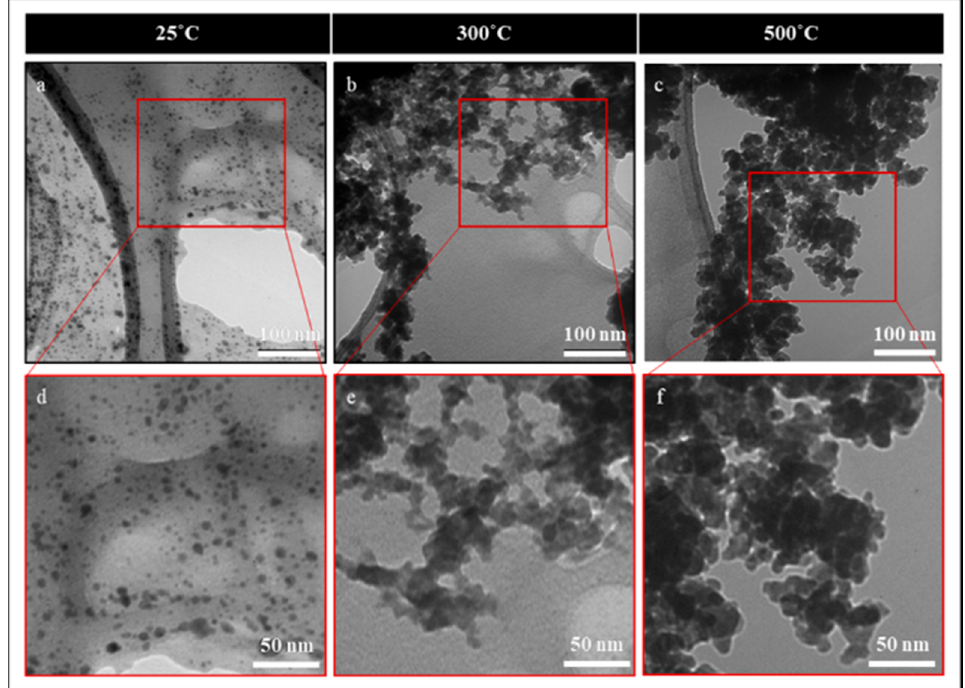
Figure 3. Transmission electron microscopy (TEM) images of the nanoparticles deposited at 2 torr in the as-deposited case ( a , d ) in addition to the baked cases at 300 °C ( b , c ) and 500 °C ( c , f ). The TEM images in the as-deposited case are well separated. However, the particles are sintering at higher temperatures.